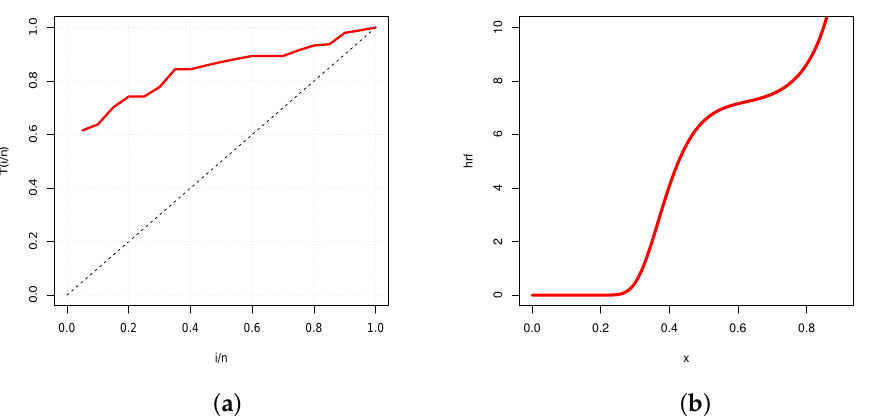
Figure 10. Plots of the ( a ) TTT plot and ( b ) estimated hrf of the UG/G model for the flood level data